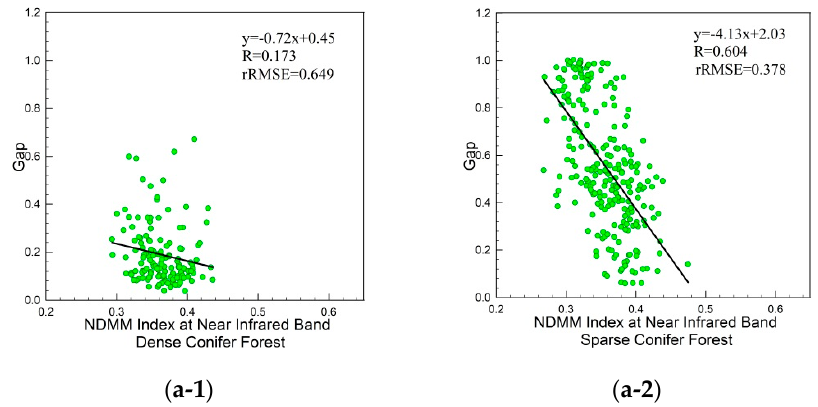
Figure 10. Relationship between the gap fraction and NDMM index at near-infrared band for dense and sparse confer forests in Howland. ( a-1 ) and ( a-2 ) represent the relationship between the gap fraction and NDMM Index at near-infrared band for the dense and sparse conifer forests respectively.